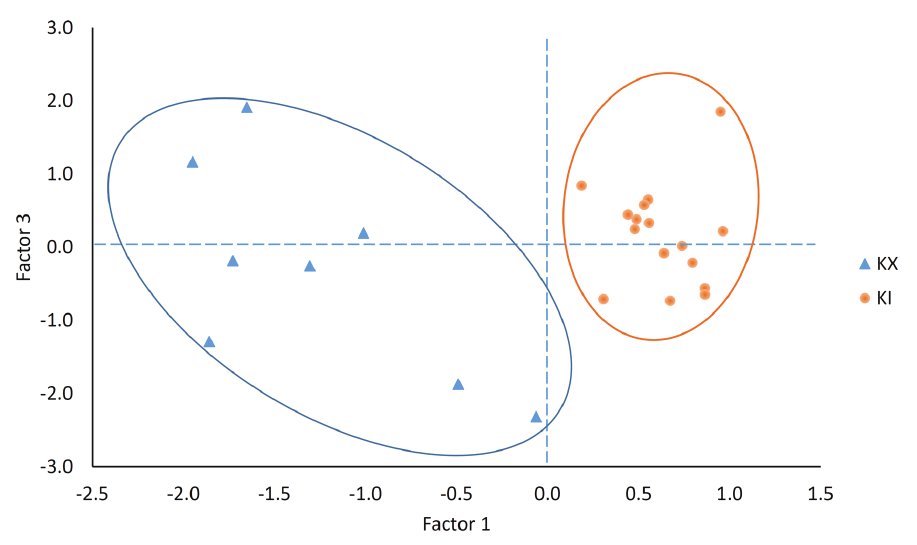
Figure 7. The PCA plot of the Kurixalus inexpectatus sp. nov. (KX) and Kurixalus idiootocus Table 7. The description results of advertisement call properties and the MANOVA test in Kurixalus inexpectatus sp. nov. and Kurixalus idiootocus . From the MANOVA test, the whole model Wilks’ val- ue = 0.087, F = 16.27, p < 0.001. “*” indicate the data are not following the assumption of normal 9,14 distribution (Shapiro-Wilk test, p < 0.05) and we transformed the data to their natural logarithm before doing statistical tests.